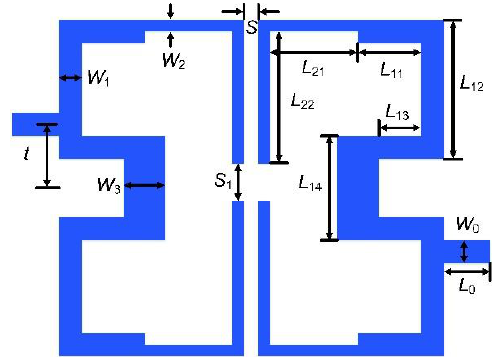
Figure 3. Schematic diagram of dual-wideband bandpass filters (BPF).